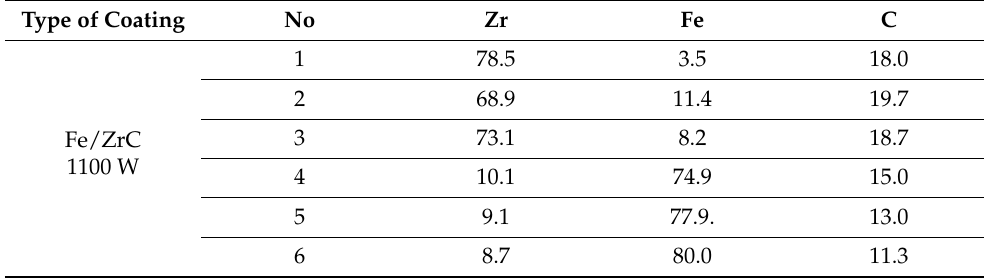
Table 3. Chemical composition (EDS) for selected area in Fe/ZrC coating produced using a laser beam power of 1100 W [wt.%].